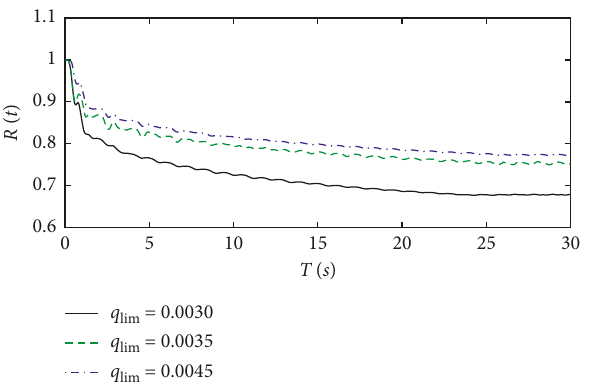
Figure 9: Dynamic reliability of bridge lateral vibration.